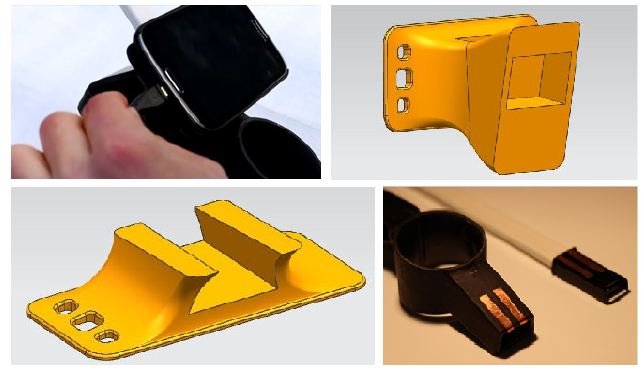
Figure 5. Ergonomic ArcAid holder for smoothless/detachable connection of ArcAid sensors and smartphone to the Geologic Startech 2 Bow.